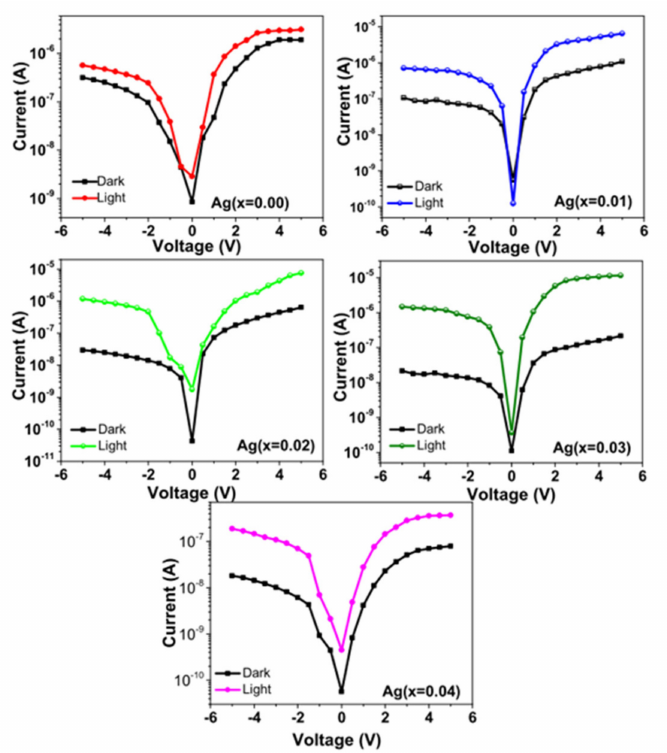
Figure 6. Light and dark current–voltage ( I–V ) characteristics of the fabricated the p -Si/ n - Cd 1–x Ag x O/Ag structures.